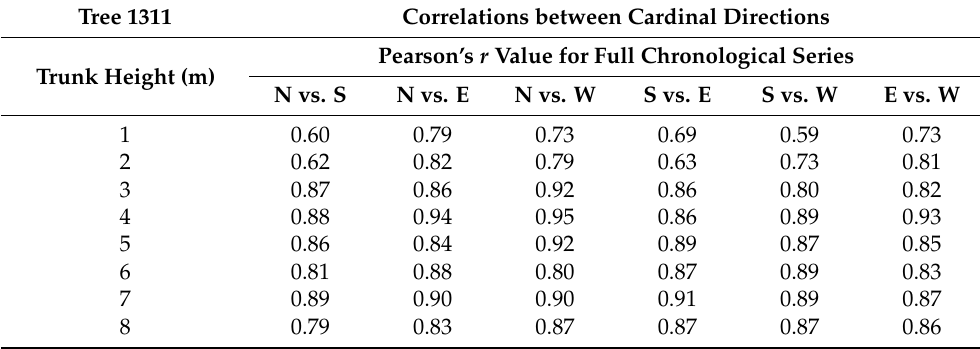
Table 3. Similarity of overall radial gišogenesis between cardinal directions at each trunk height in tree 1311. Tree 1311 Correlations between Cardinal Directions Trunk Height